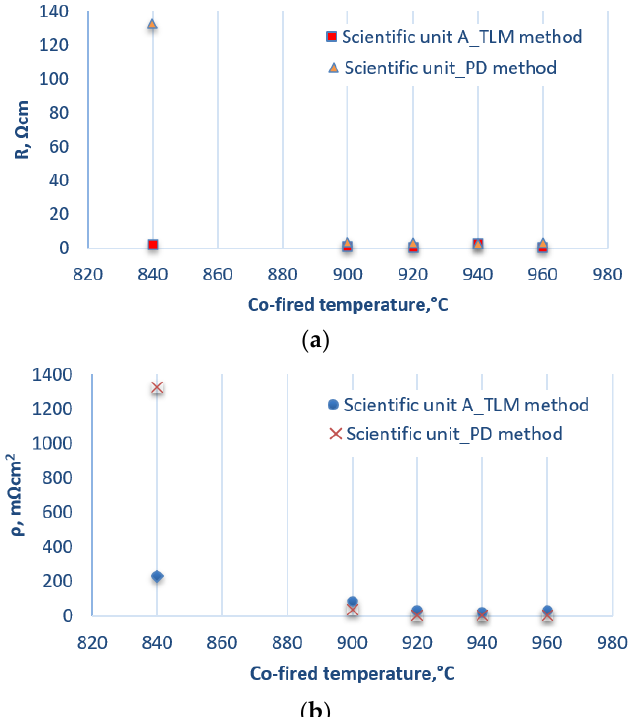
Figure 4. List of electrical parameters—( a ) resistance and ( b ) resistivity—of photovoltaic cells with a front electrode applied using a template and made of commercial PV19B paste [34].